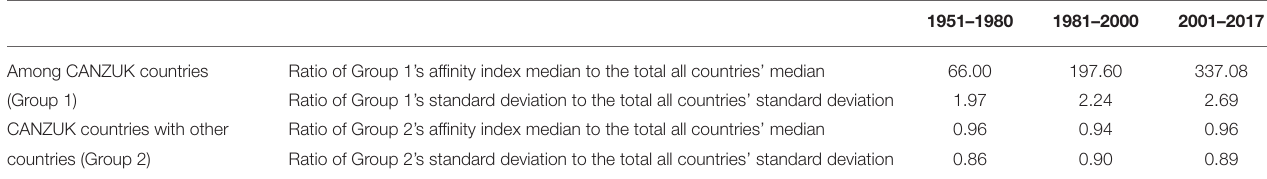
TABLE 4 | Comparing the ratios of medians and standard deviations of affinity index values of each group to the values of the total all countries, using the fractional counting